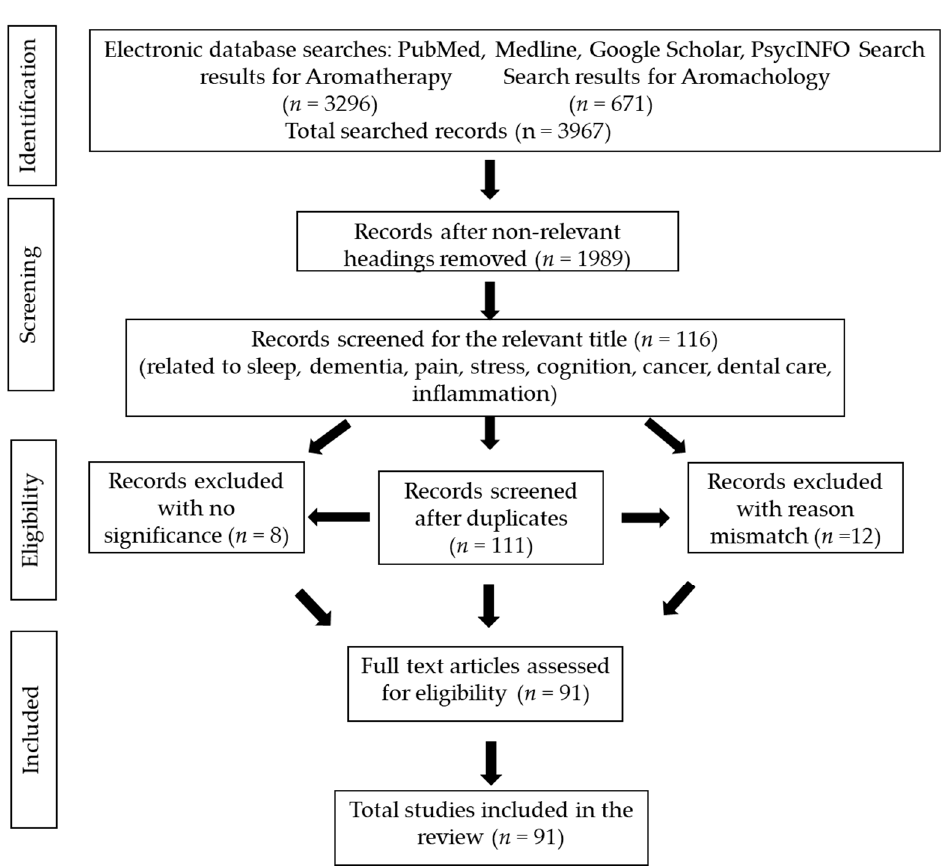
Figure 1. Schematic representation of the PRISMA chart explaining the selection of studies.